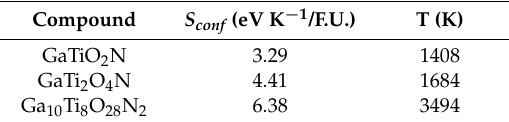
Table 2. Configurational entropies and calculated temperatures needed to stabilize given